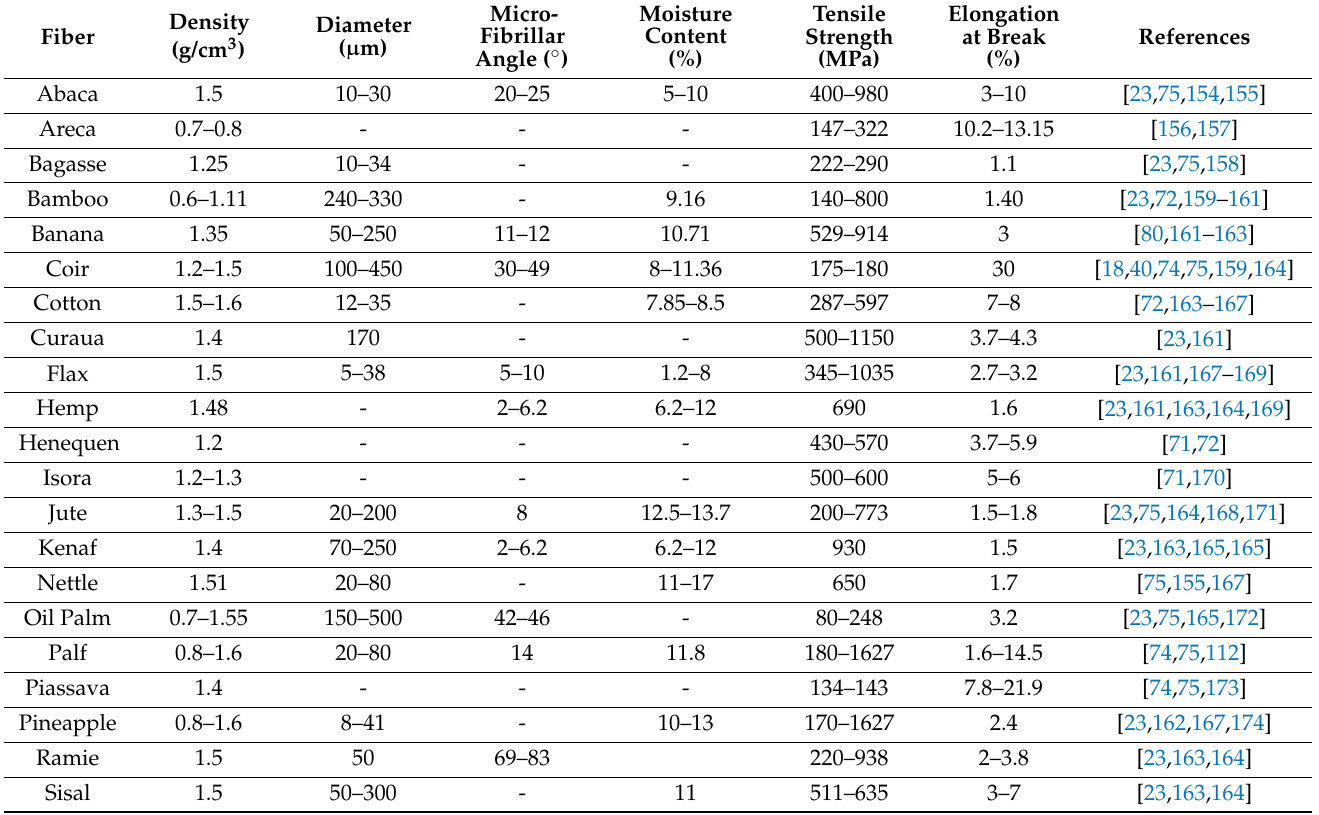
Table 3. Mechanical properties of different natural